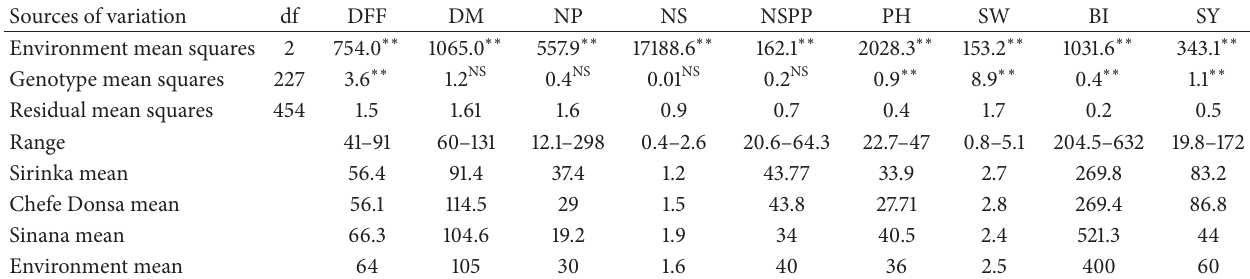
Table 7: Mean squares of the combined analysis of variance for lentil yield and yield component traits and mean values for each location in the 2011/12 cropping season.